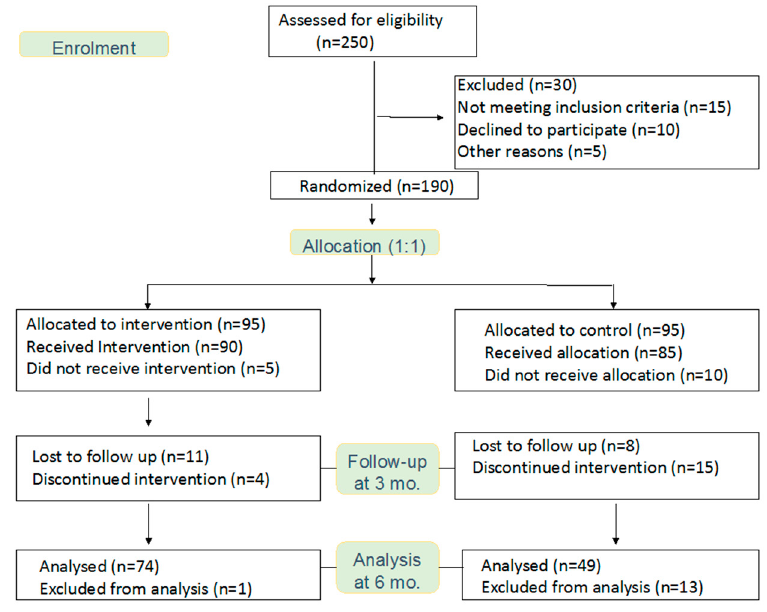
Figure 1. Flow chart.